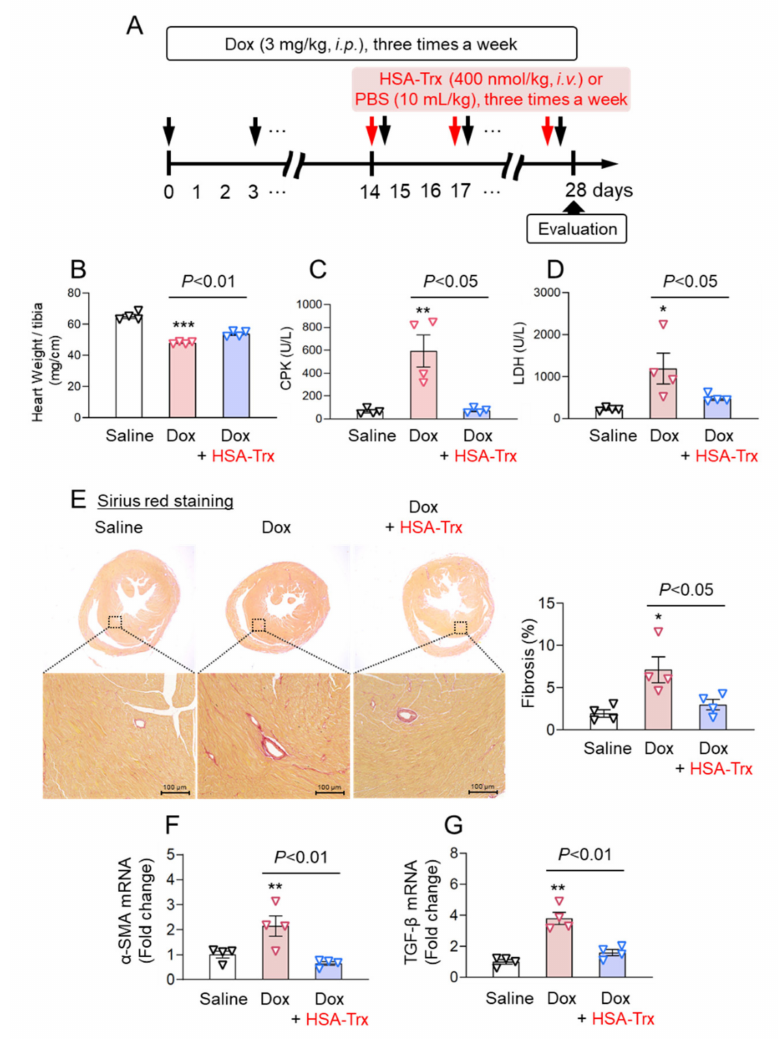
Figure 1. Effect of HSA-Trx on myocardial atrophy and fibrosis in the heart of Dox-induced cardiomy- opathy model mice. ( A ) Experimental protocol used for the evaluation of HSA-Trx on Dox-induced cardiomyopathy model mice: Dox-induced heart failure was induced by an intraperitoneal injec- tion of 3 mg/kg Dox three times per week for 4 weeks. HSA-Trx (400 nmol/kg) was administered i.v. three times a week at 2 weeks after the first injection of Dox. An equivalent amount of PBS (10 mL/kg) was administered to the saline injection group (normal mice) and the Dox injection group. ( B ) Heart weight at 4 weeks after the first injection of Dox. Change in the level of ( C ) creatine phosphokinase (CPK) and ( D ) lactate dehydrogenase (LDH) at 4 weeks after the first injection of Dox. ( E ) Representative photomicrographs of Sirius red-stained heart sections at 4 weeks after the first injection of Dox. Original magnification: × 200. Scale bars represent 100 mm. Image analysis was performed to quantify the area of Sirius red staining. ( F ) α -SMA and ( G ) TGF- β mRNA expression in the heart at 4 weeks after the first injection of Dox were determined by real-time qPCR. Results are the means ± S.E. ( n = 4). * p < 0.05, ** p < 0.01, *** p < 0.001 compared with the saline injection group (normal